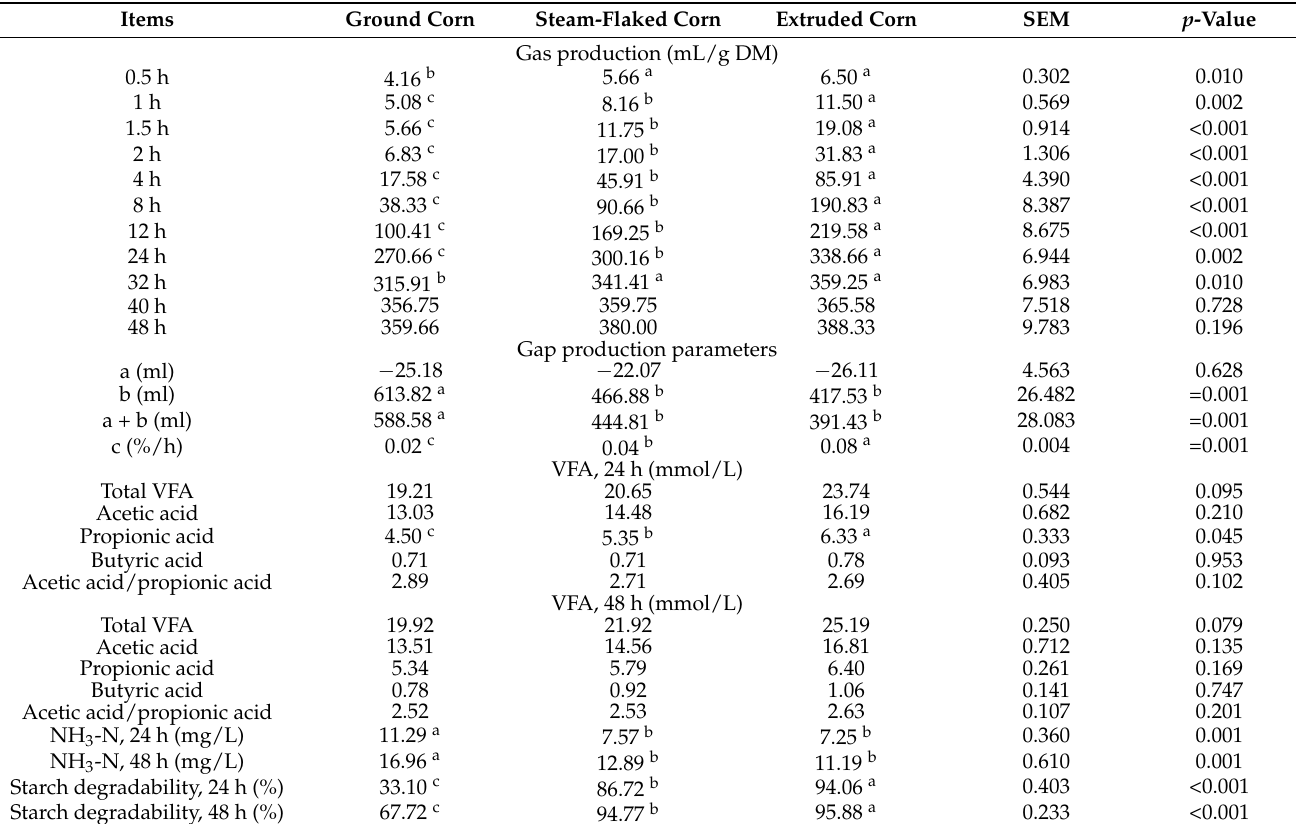
Table 2. In vitro ruminal fermentation parameters of corn processed in different